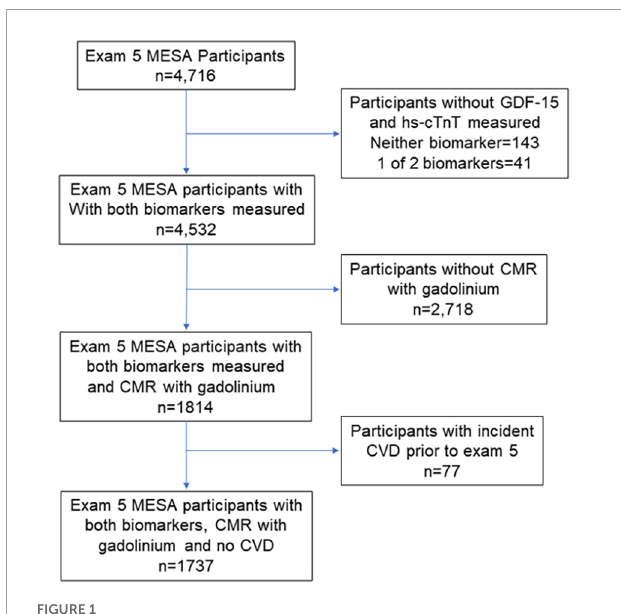
FIGURE1 Consort diagram of the Multi-Ethnic Study of Atherosclerosis (MESA) participants at exam 5 (years 2010-2012) who had biomarkers retrospectively measured and cardiac magnetic resonance (CMR) performed with gadolinium.